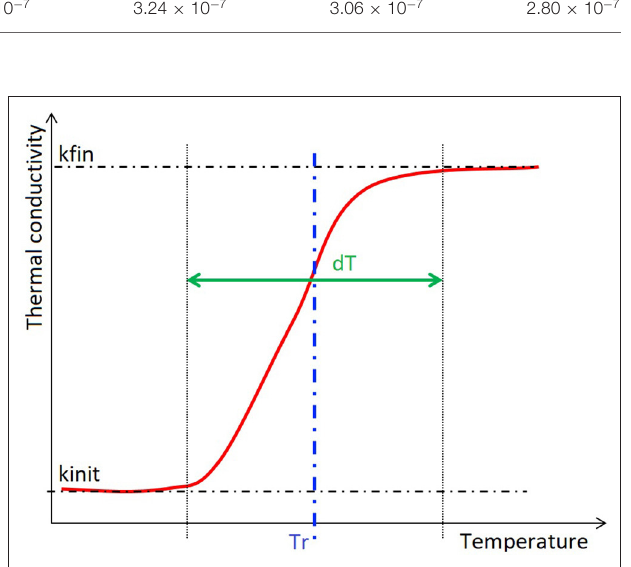
FIGURE 4 | Evolution of thermal conductivity of interlaminar interfaces with